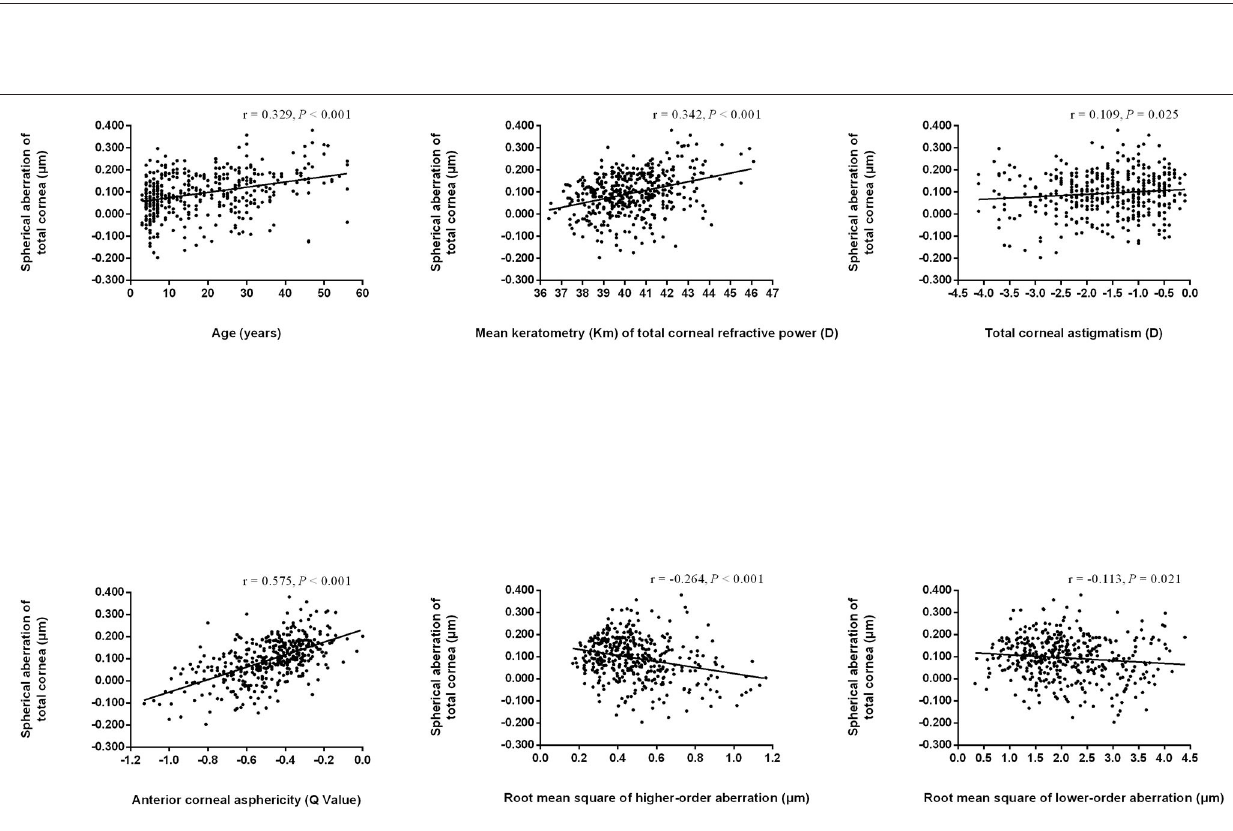
Frontiers in Medicine |